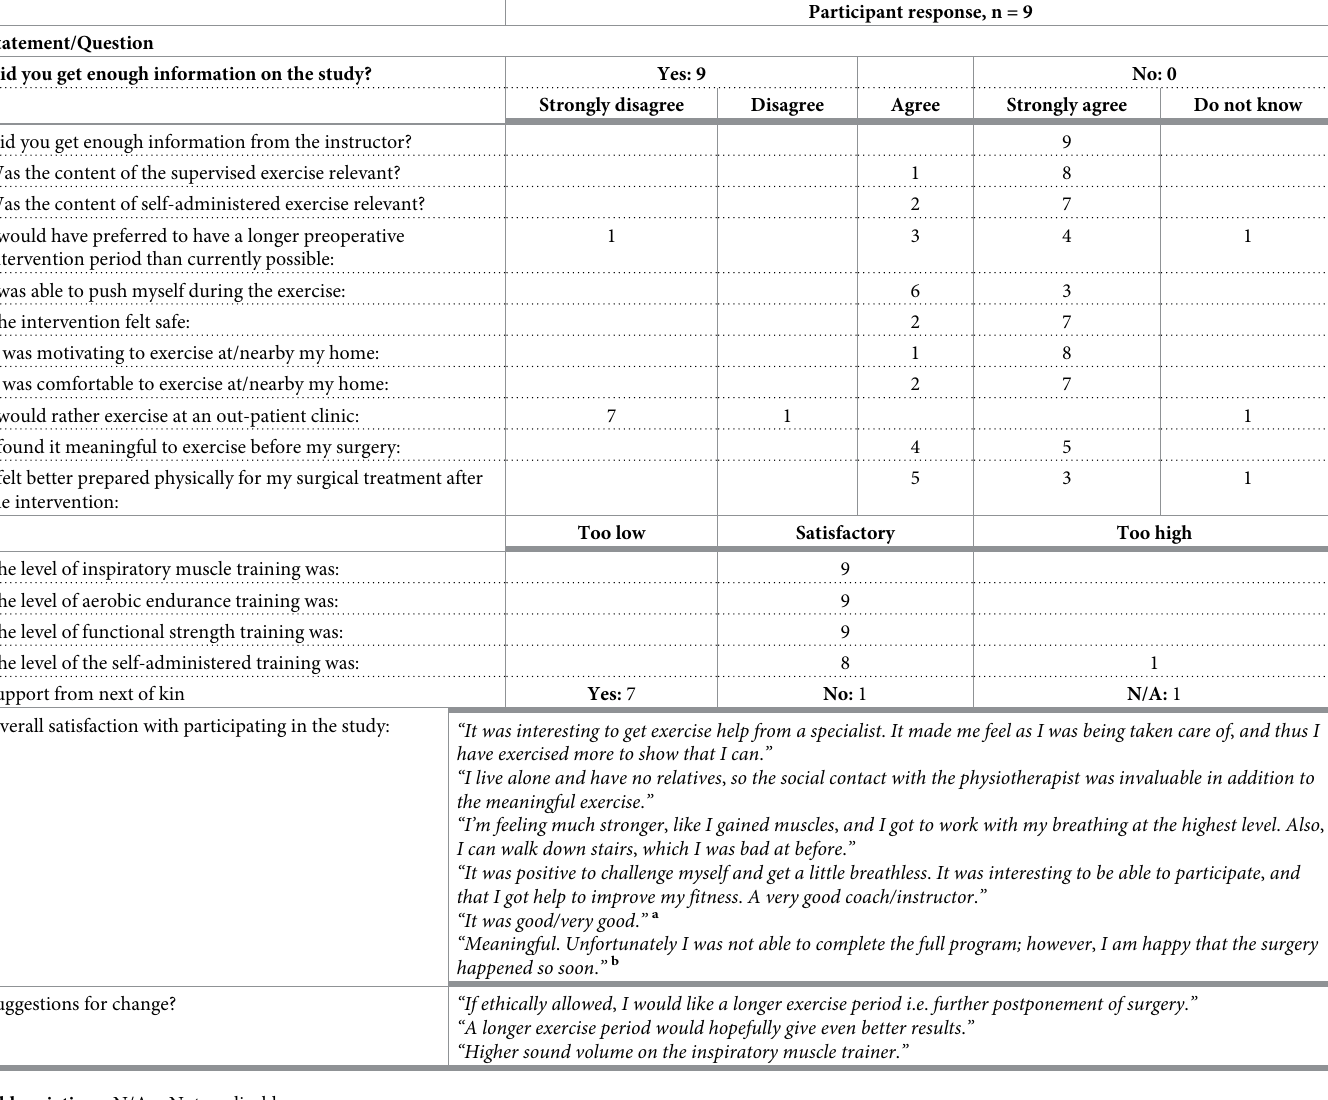
Table 2. Participant satisfaction with the exercise intervention (n = 9, one participant did not